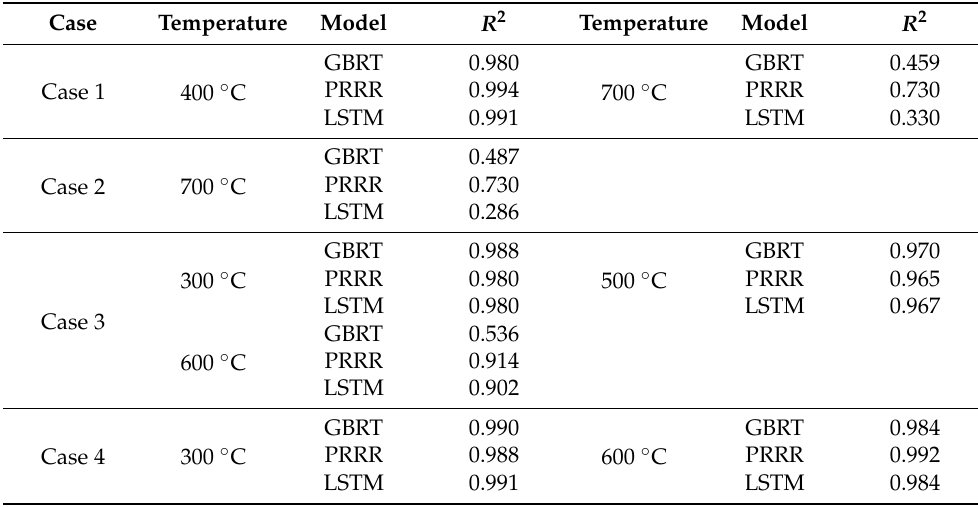
Table 2. Determination coefficient R 2 between the predicted values and the experimental ones under special temperatures for the four cases of different training sets and testing sets in Table